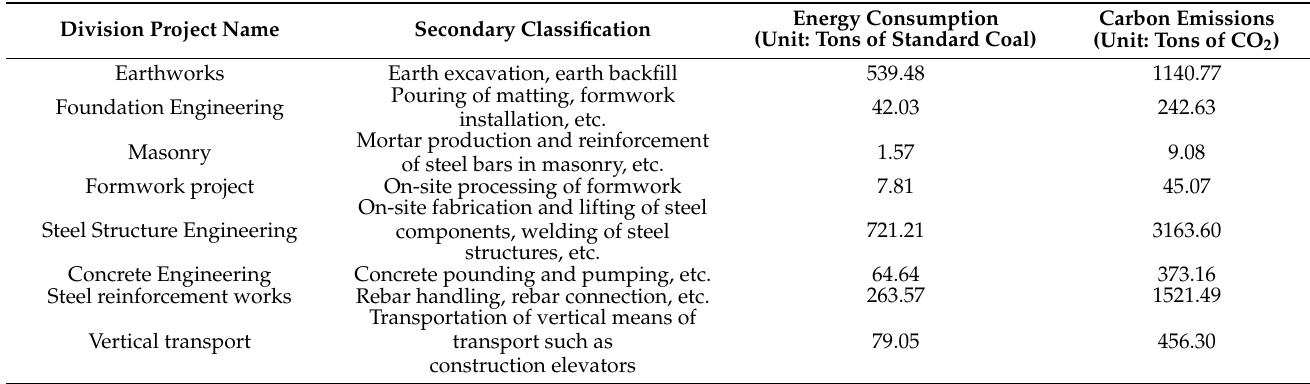
Table 5. Energy consumption and carbon emission of